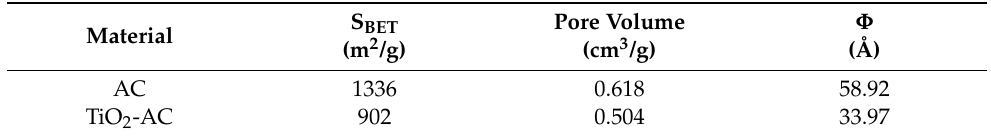
Table 1. Textural properties determined by N 2 physisorption and BET modeling of AC and TiO 2 -